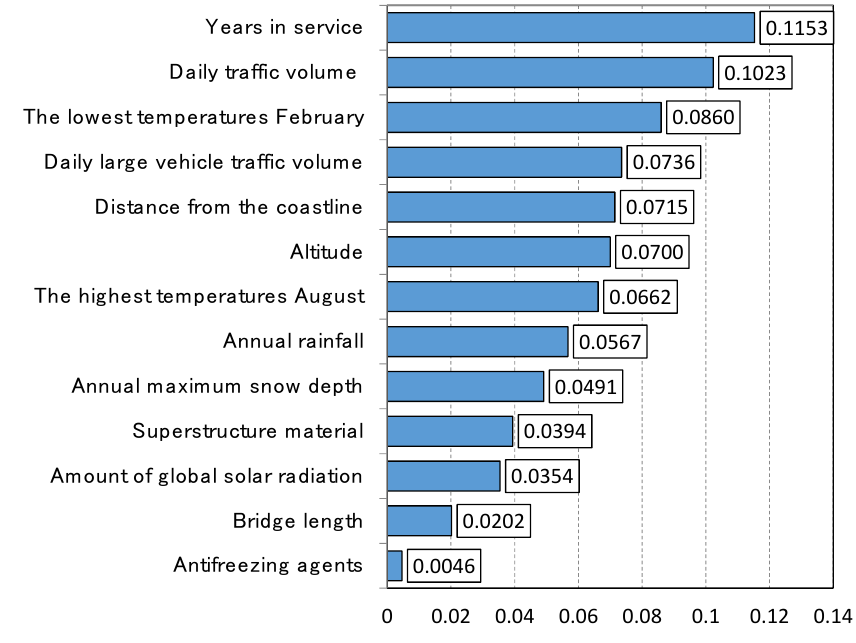
Figure 6. Range of each factor (slabs).